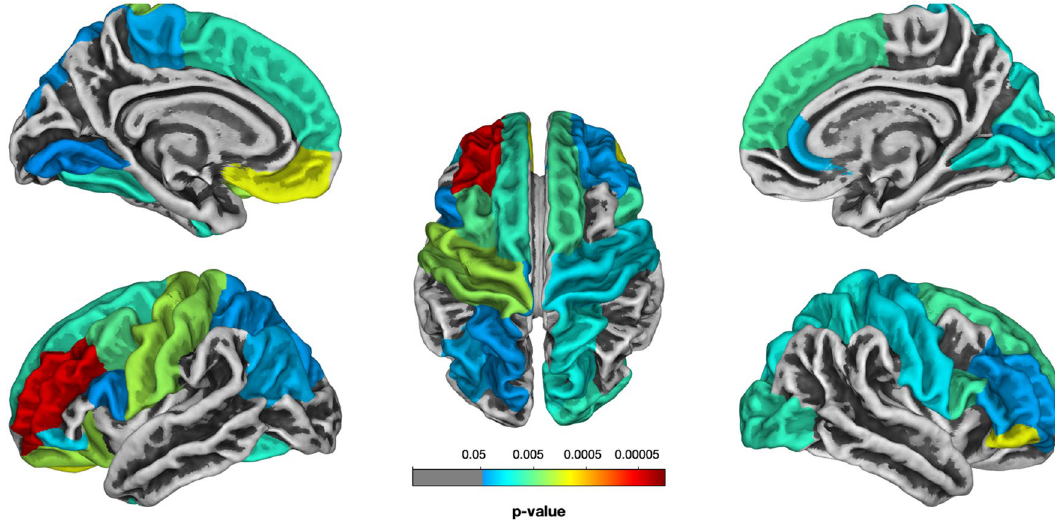
Figure 4. The statistical map for the whole-brain analysis in GM thickness (difference between ASD and TD groups of children, Holm-Bonferroni corrected p <